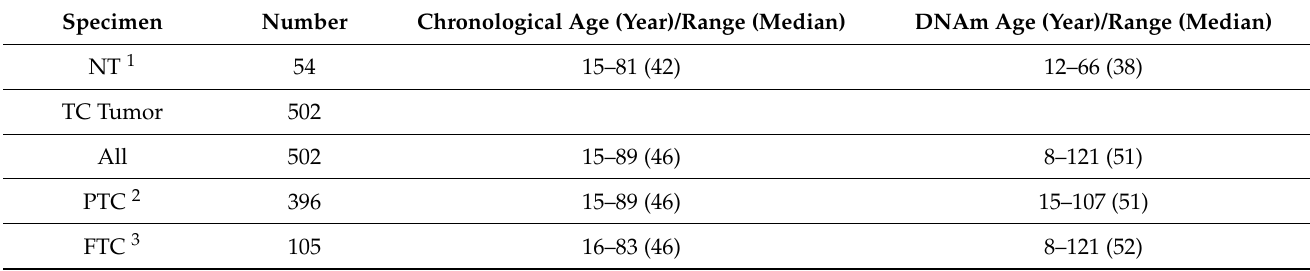
Table 2. Chronological and DNAm age in non-tumorous thyroid tissues and tumors from patients with thyroid carcinoma.